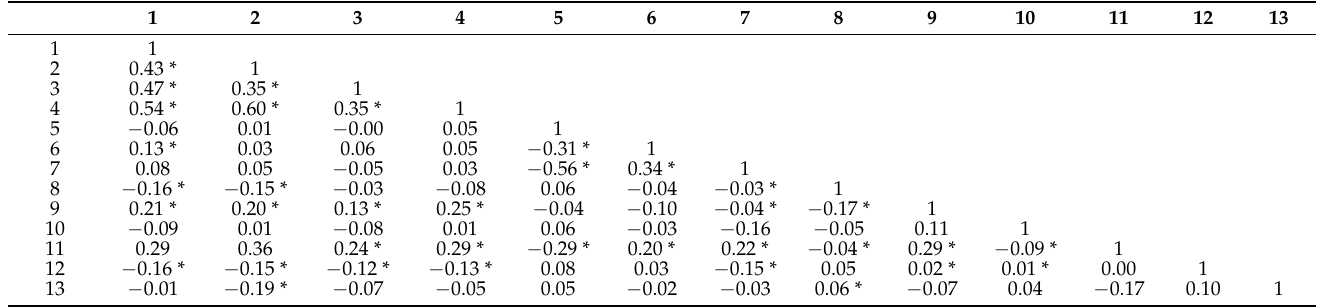
Table 3. Correlations Between Problem-solving abilities and Other Variables in Participants (N = 260).